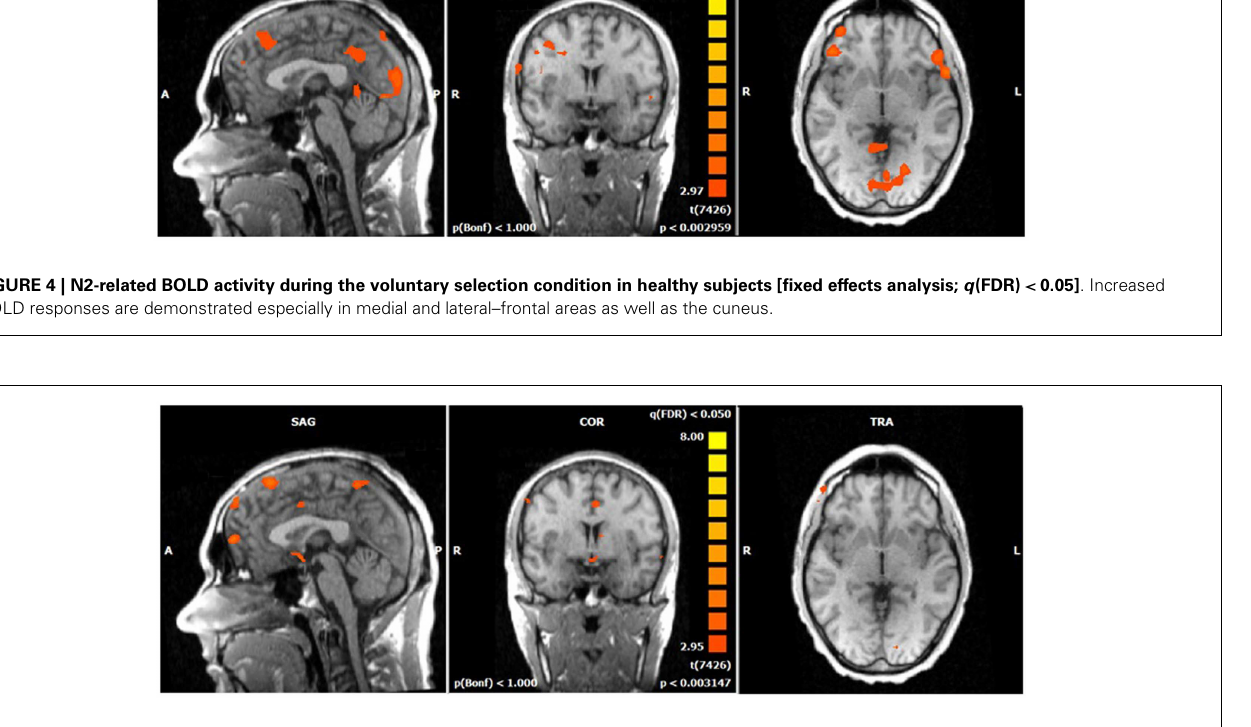
FIGURE 5 | N2-related BOLD activity during the voluntary selection condition inADHD patients [fixed effects analysis; q (FDR) < 0.05] . Increased BOLD responses are demonstrated in the same brain network as in healthy subjects including medial and lateral–frontal areas as well as the